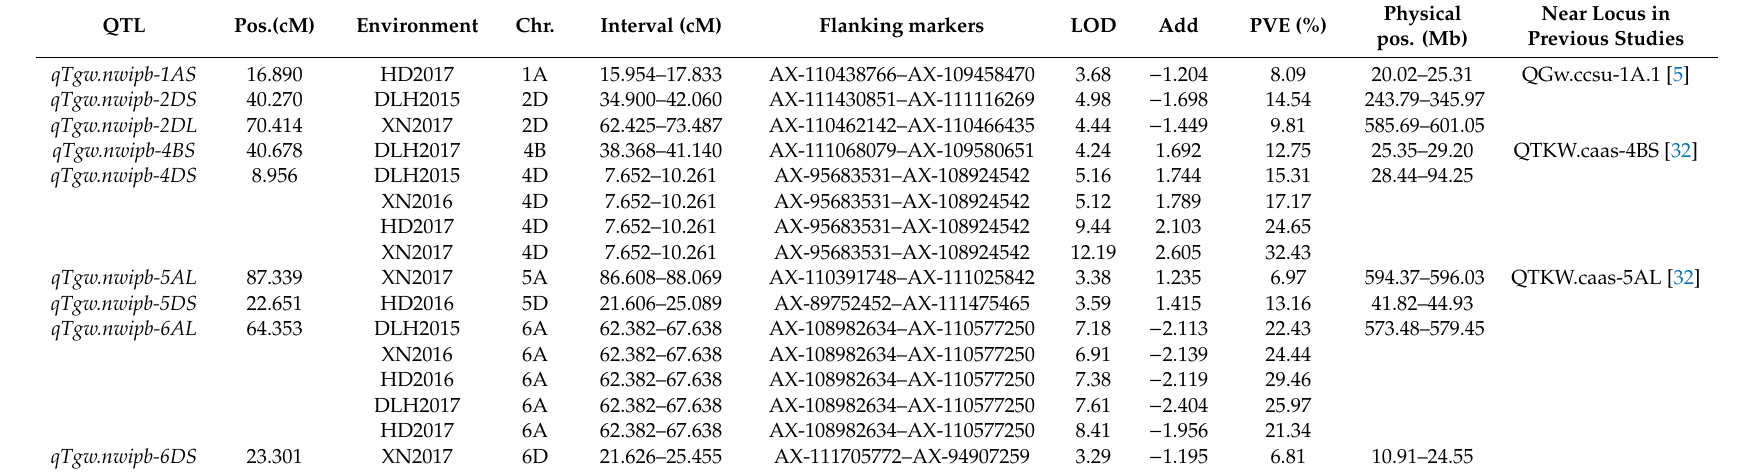
Table 3. Quantitative trait locus (QTL) for the TGW traits in di ff erent